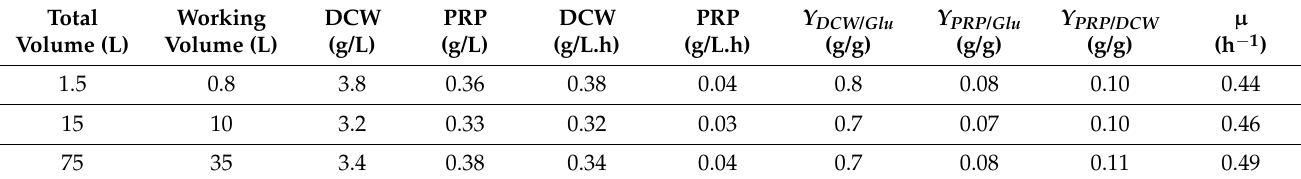
Table 3. Comparison of cultures’ yields and conversion factors obtained during the scale-up process of H. influenzae using k L a criterion performed in 1.5 L bench-scale, 15 L bench-scale and 75 L pilot-scale bioreactor systems during 10 h of culture.